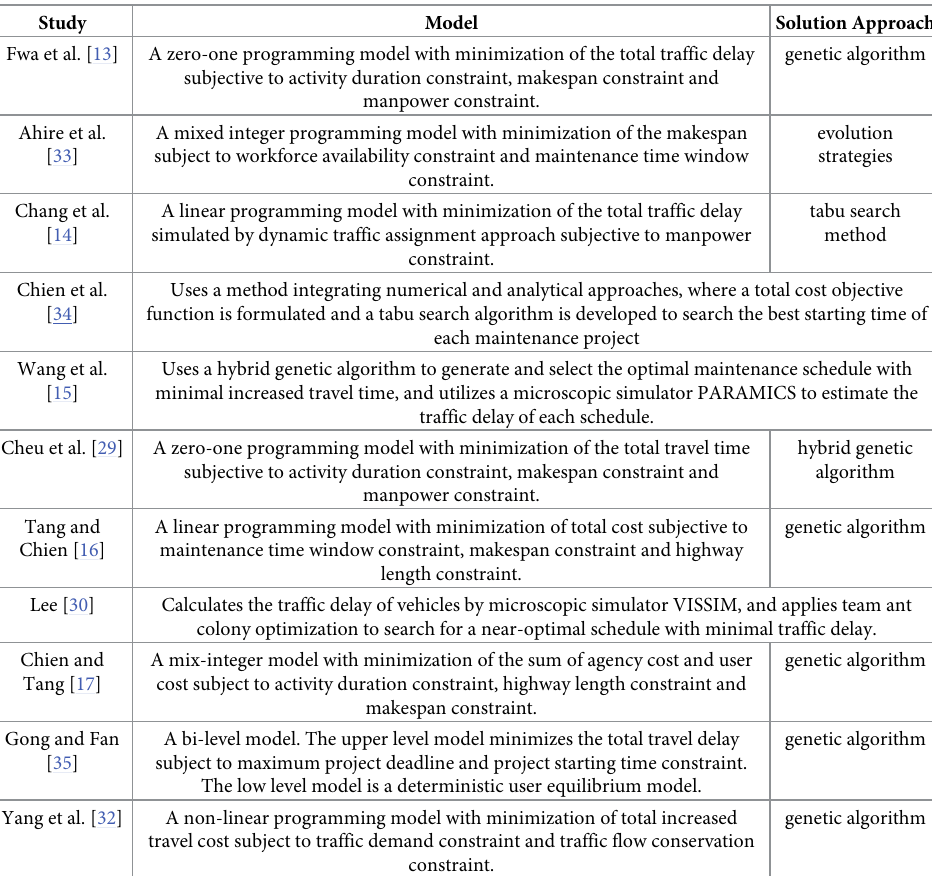
Table 1. Summarization of the existing studies of